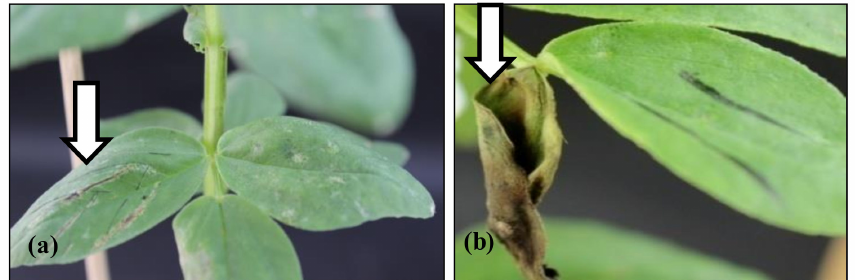
Figure 1. Herbicide leaf paint test showing ( a ) resistance of a transgenic plant to BASTA ® application (300 mg/L ammonium glufosinate); ( b ) the control non-transgenic leaf dying after BASTA ® application.